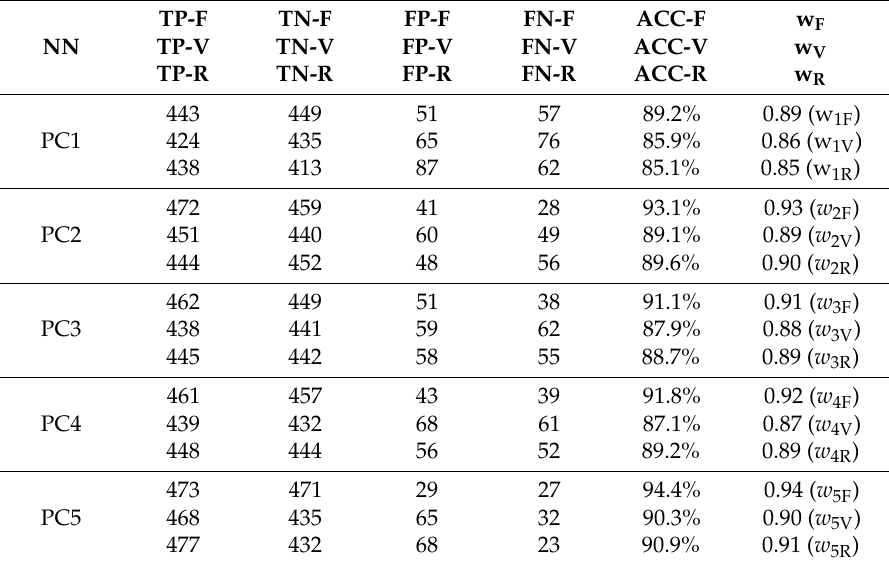
Table 3. Associated weights for the primary classifiers